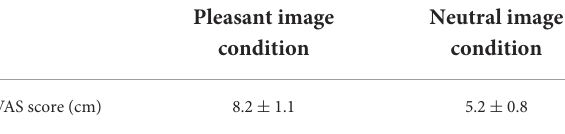
TABLE 2 VAS scores in the pleasant and neutral image